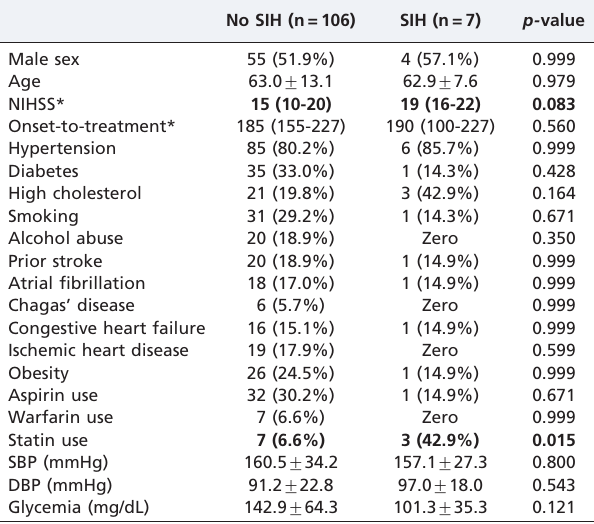
Table 2 - Univariate analysis.